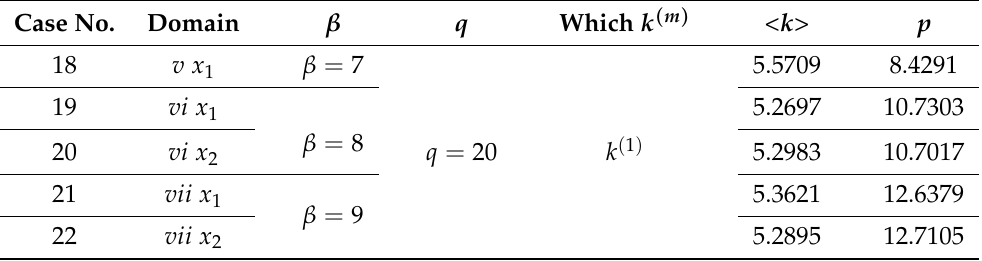
Table 2. Average carrying capacity < k > and quantity p (see relation (18)) calculated for the persistence clusters shown in Figure 8.